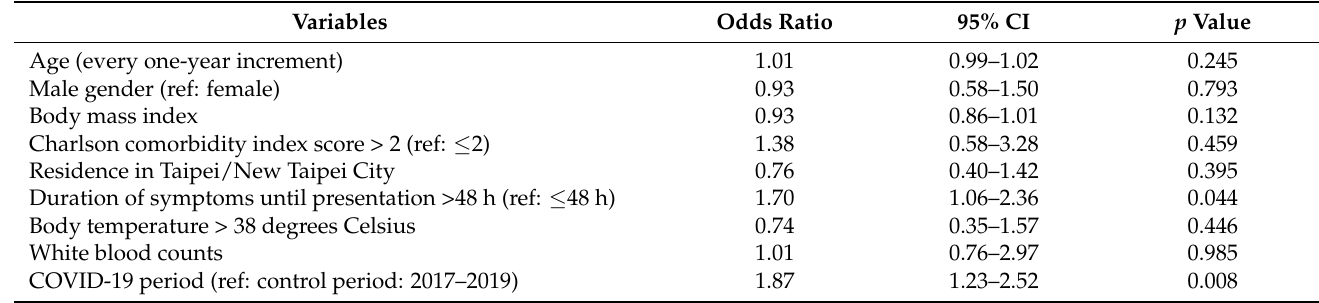
Table 3. Adjusted multivariate analysis used to predict complicated appendicitis.